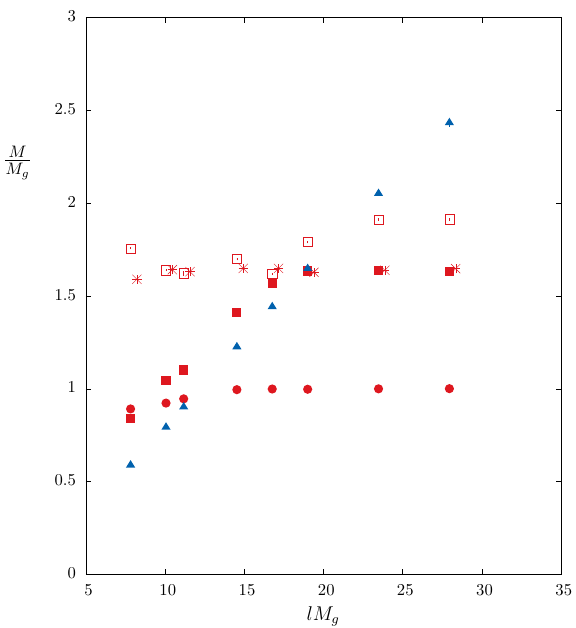
Figure 1 . Lightest J P = 0 + ( (cid:15) ), 2 + ( (cid:4) ) and 2 (cid:0) ( ? ) glueball masses in SU(2) at (cid:12) = 12 : 0 on various spatial volumes, l 2 , all in units of the in(cid:12)nite volume mass gap M g . The 2 (cid:0) has been shifted for clarity. Also shown is the (cid:12)rst excited 2 + ( (cid:3) ) glueball mass and twice the fundamental (cid:13)ux loop energy ( N